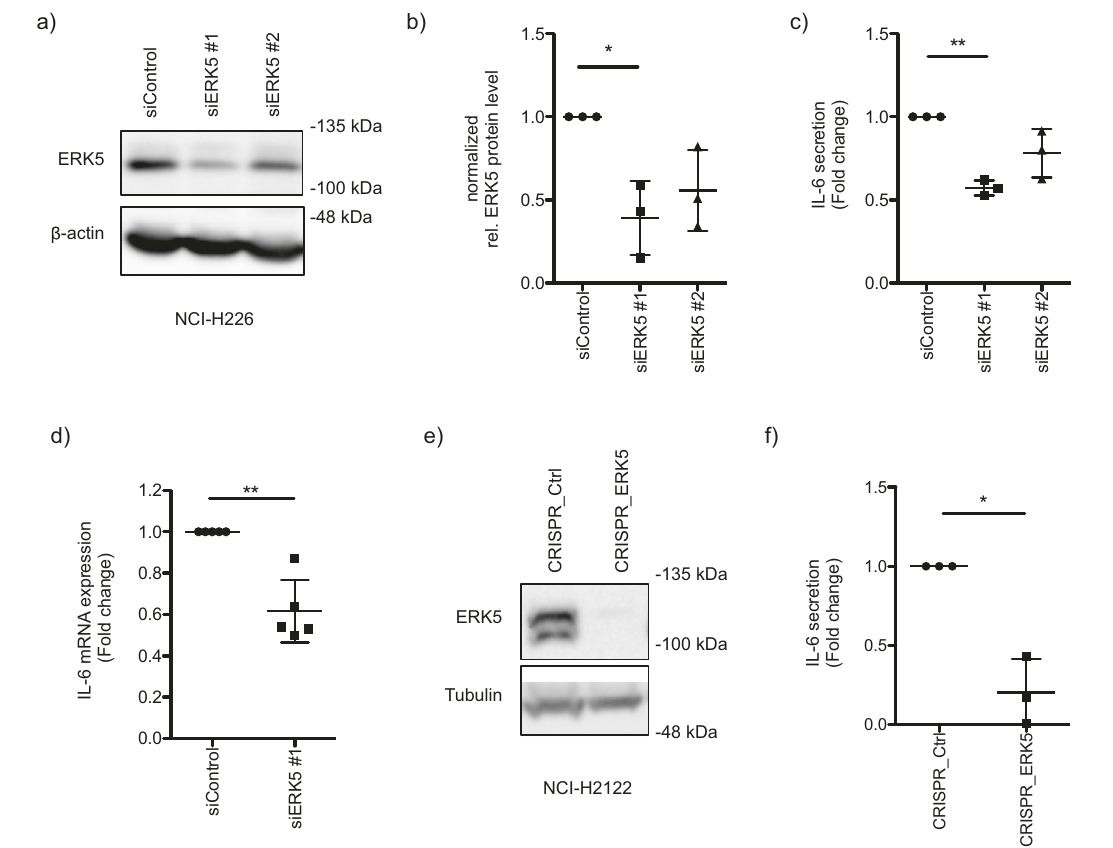
Fig. 6 ERK5-speci fi c effect on IL-6 secretion. a siRNAs were transfected to speci fi cally knockdown ERK5 in NCI-H226 cells and the knockdown of ERK5 was con fi rmed by Western blot analysis. b The siRNA-mediated knockdown ef fi ciency was quanti fi ed by normalizing the ERK5 levels to the corresponding tubulin or ponceauS staining (mean fold change ± SD; n = 3). c Same as in a, but after 72 h IL-6 secretion was studied by ELISA. Therefore, the medium was replaced by a fresh medium, and the supernatant was harvested after 6 h of incubation to determine IL-6 secretion (mean fold change ± SD; n = 3). d Same as in a, but IL-6 mRNA levels were determined by qPCR 48 h after siRNA transfection (mean fold change ± SD; n = 5). e CRISPR/Cas-mediated knockout of ERK5 was induced in NCI-H2122 cells and con fi rmed by Western blot analysis. f NCI-H2122 cells transfected with CRISPR_Control or CRISPR_ERK5 were seeded in 12-well plates. After cells have adhered overnight, the medium was changed to a fresh culture medium. The supernatant was harvested after 6 h of incubation and IL-6 secretion was studied by ELISA (mean fold change ± SD; n = 3).